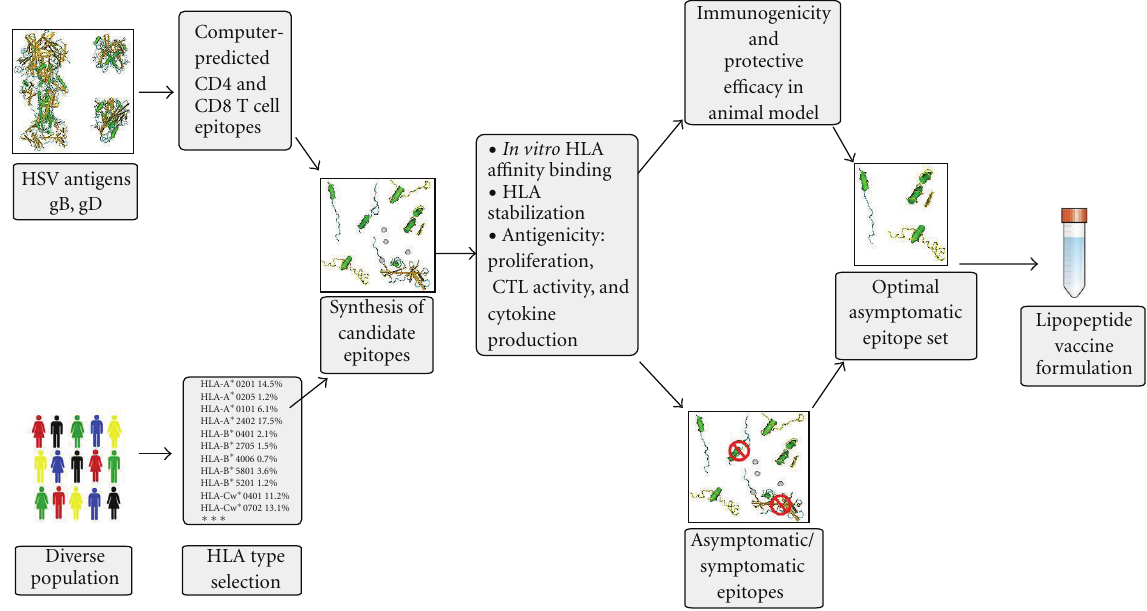
Figure 2: Illustration of steps in developing an asymptomatic lipopeptides-base herpes vaccine. The lipopeptide vaccine formulation is developed following multistep strategy. This starts from the identification of a symptomatic and asymptomatic herpes population and highly immunogenic HSV proteins. Next, asymptomatic CD4 + and CD8 + T-cell epitopes are discovered and covalently linked to a TLR2 agonist (Palmitic acid) leading to self-adjuvanting lipopeptides